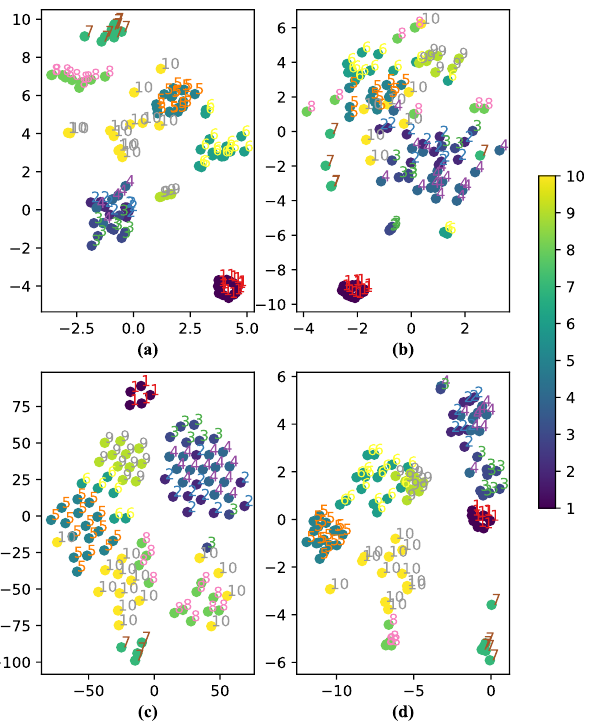
Figure 5. The t-SNE visualized feature distribution in 1:100 balance ratio between different oversam- pling techniques on the CNN model: ( a ) NR; ( b ) SMOTE; ( c ) GAN and ( d )